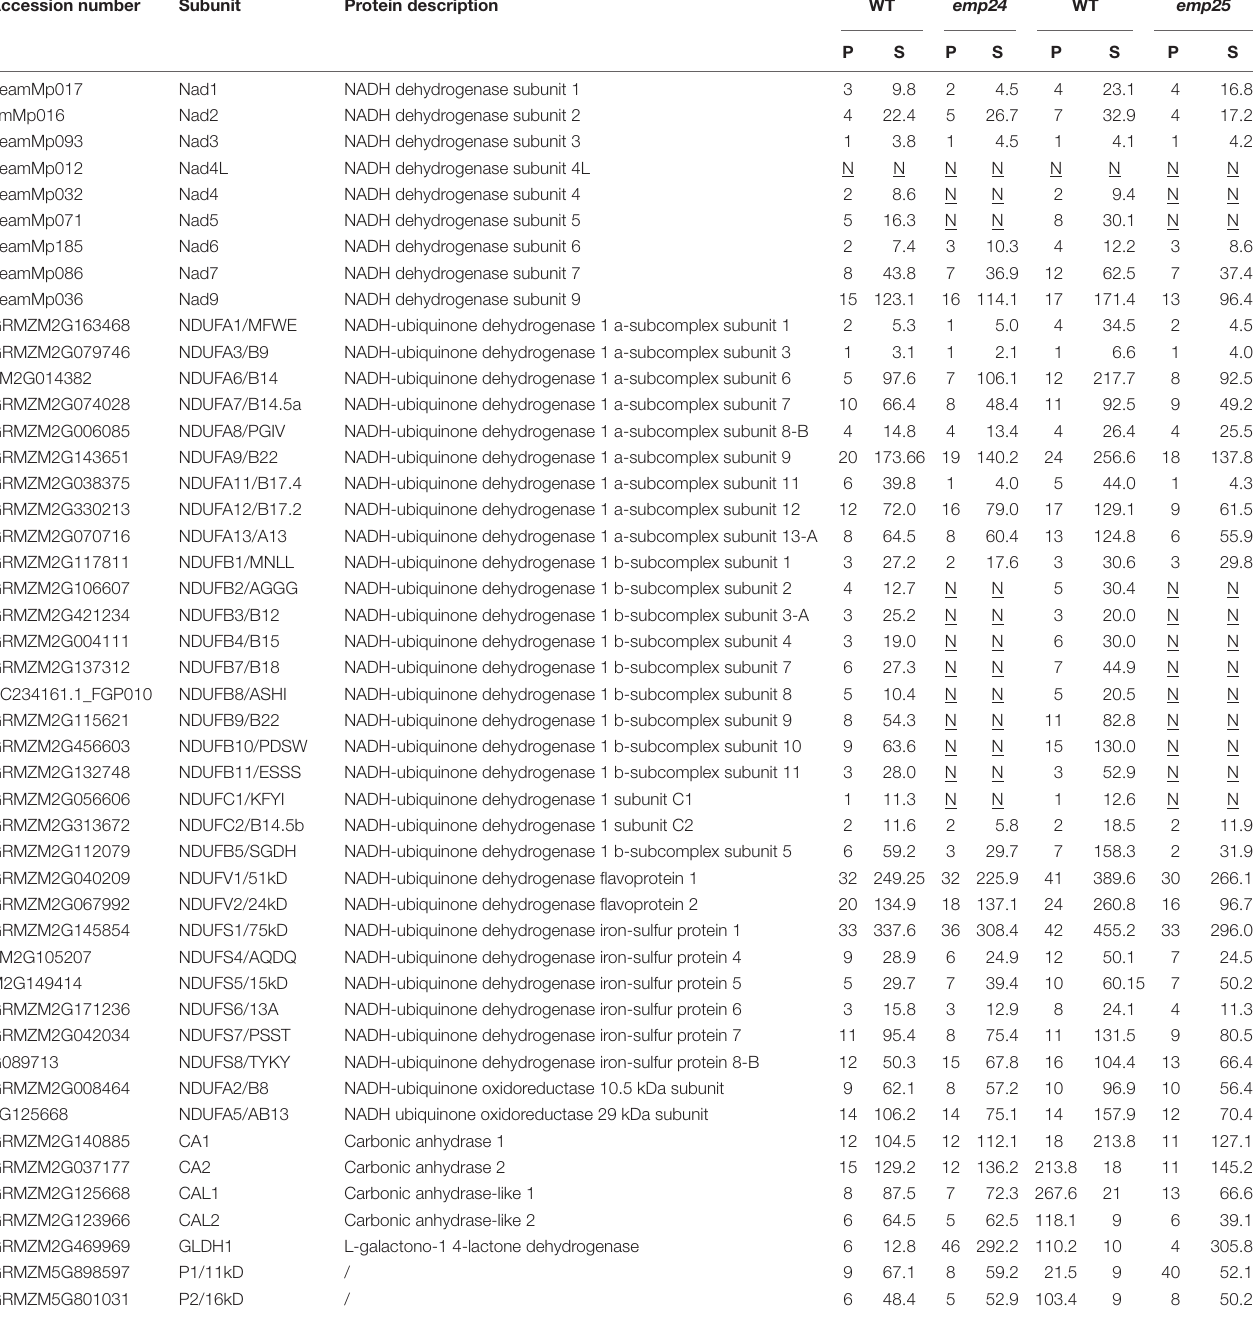
TABLE 1 | Protein mass spectrometry analysis of complex I subunits in emp24 and emp25. Accession